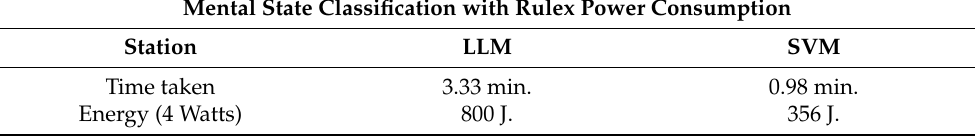
Table 4. Power consumption for Mental State Classification with the Raspberry Pi.